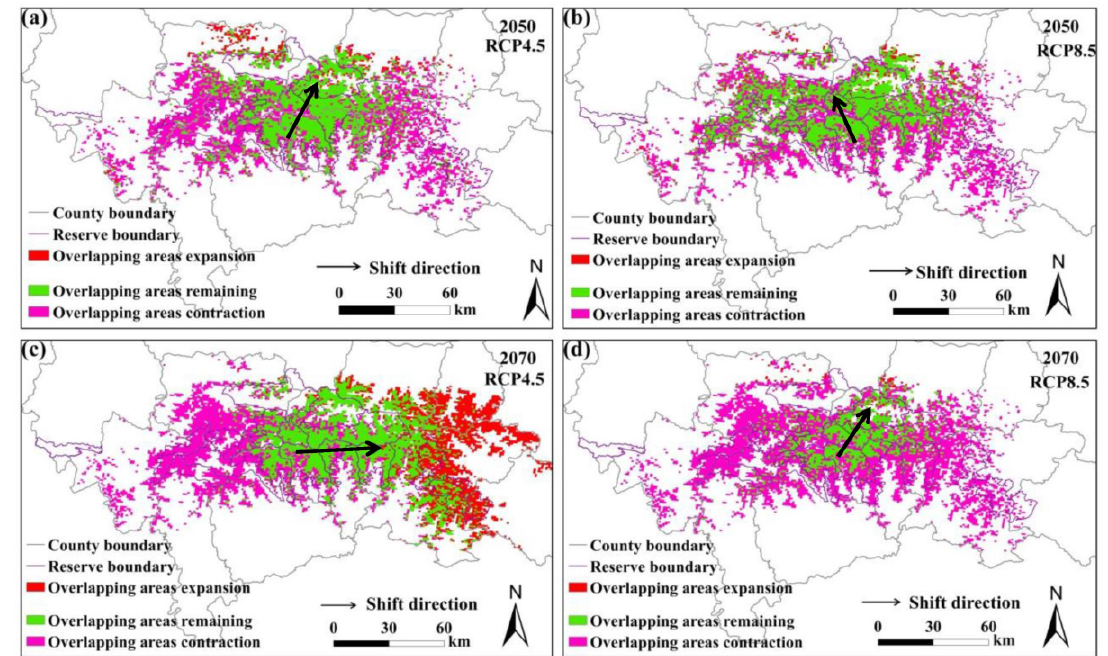
Figure 4. Overlapping suitable habitats of giant pandas and wild boars under different climate change scenarios. ( a , b ) represent the changes under the RCP4.5 and RCP8.5 scenarios in 2050s, respectively; ( c , d ) represent the changes under the RCP4.5 and RCP8.5 scenarios in 2070s, respectively.